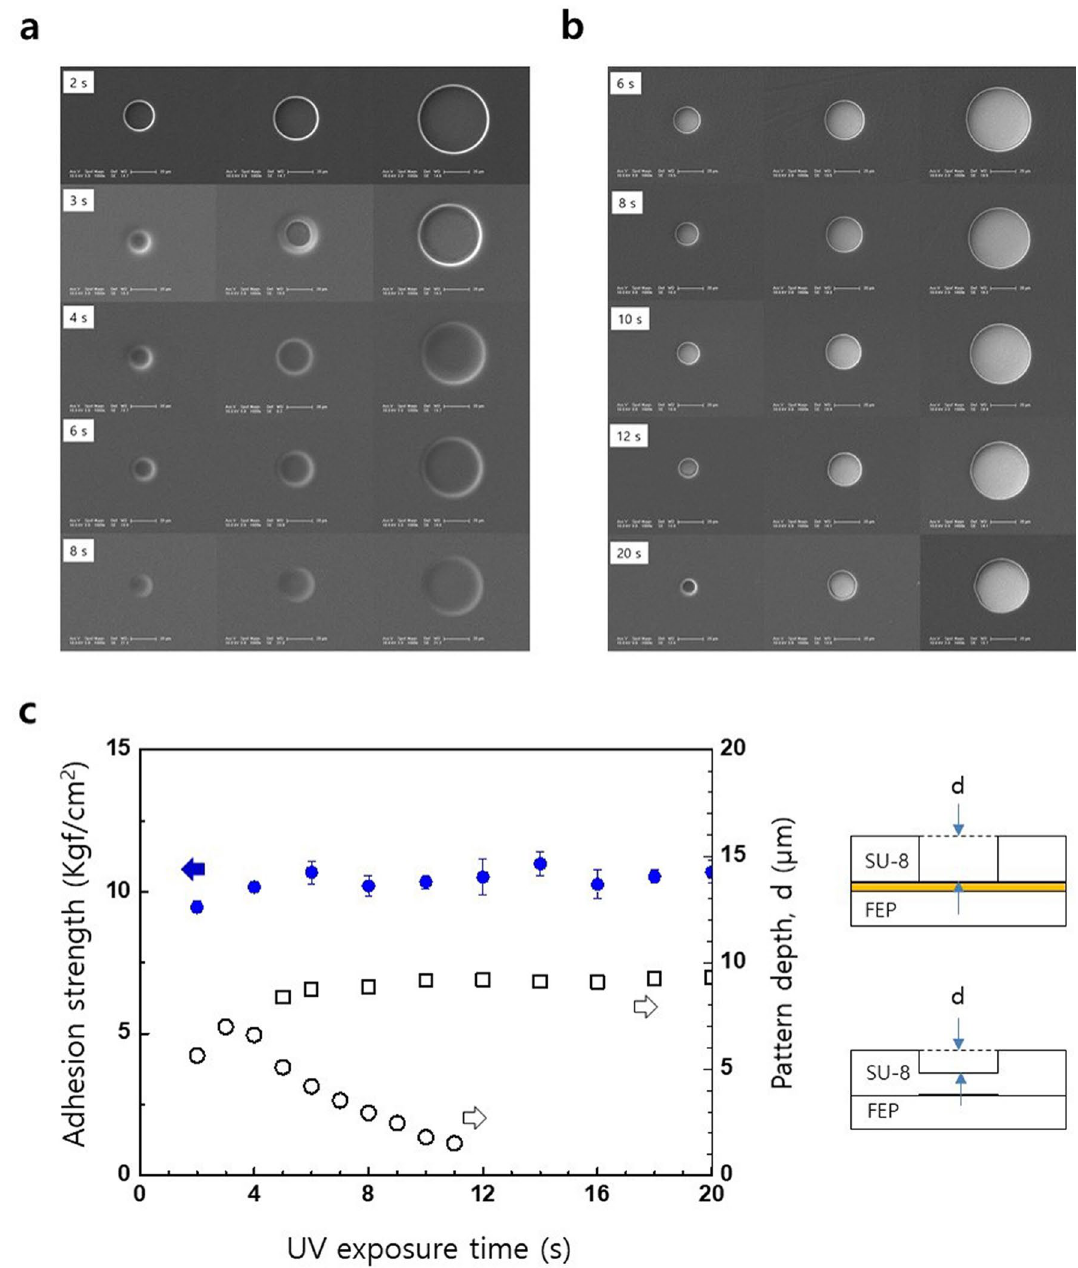
Figure 3. FESEM images of 20-μm (left), 30-μm (centre), and 50-μm (right) SU-8 patterns photopatterned on plasma-treated FEP (@ 20 W, 1 min) ( a ) and on an Au layer ( b ) with respect to UV exposure time. ( c ) The AS between SU-8 and FEP (closed circle in blue), the pattern depth of SU-8 on Au layer (open rectangle), and that of SU-8 on FEP (open circle) with respect to UV exposure time. Pattern depth data were obtained from 50-μm line patterns via step profilometer (Alpha-step 500, KLA-Tencor). Multiplying the UV exposure time by the power density (22.7 mW/cm 2 @ 365 nm) yields the exposure dose in units of mJ/cm 2